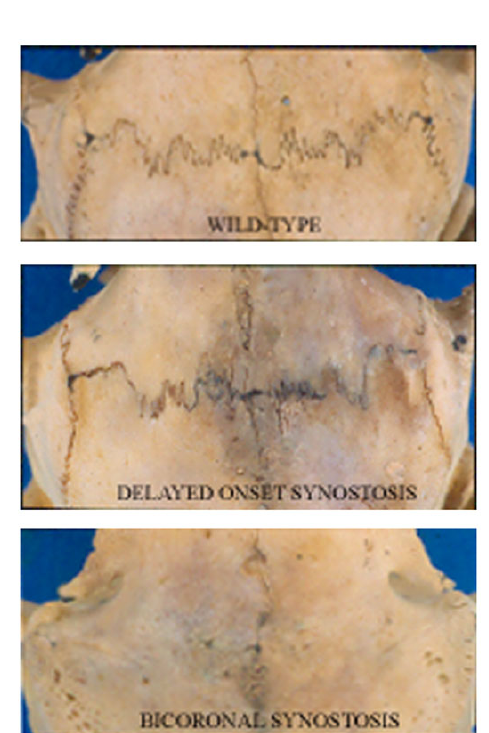
Figure 2. Superior view of the coronal suture from a 42 day wild-­‐type normal control rabbits and rabbits with late-­‐onset (postnatal) and early-­‐onset (prena-­‐ tal) coronal suture synostosis. Note the obliterated coronal suture in the early-­‐onset synostosis rabbit skull (bottom picture), the dysmorphic and incom-­‐ plete coronal suture in the late-­‐onset synostosis rabbit skull (middle picture), compared to a normal coronal suture in the wild-­‐type rabbit skull (top